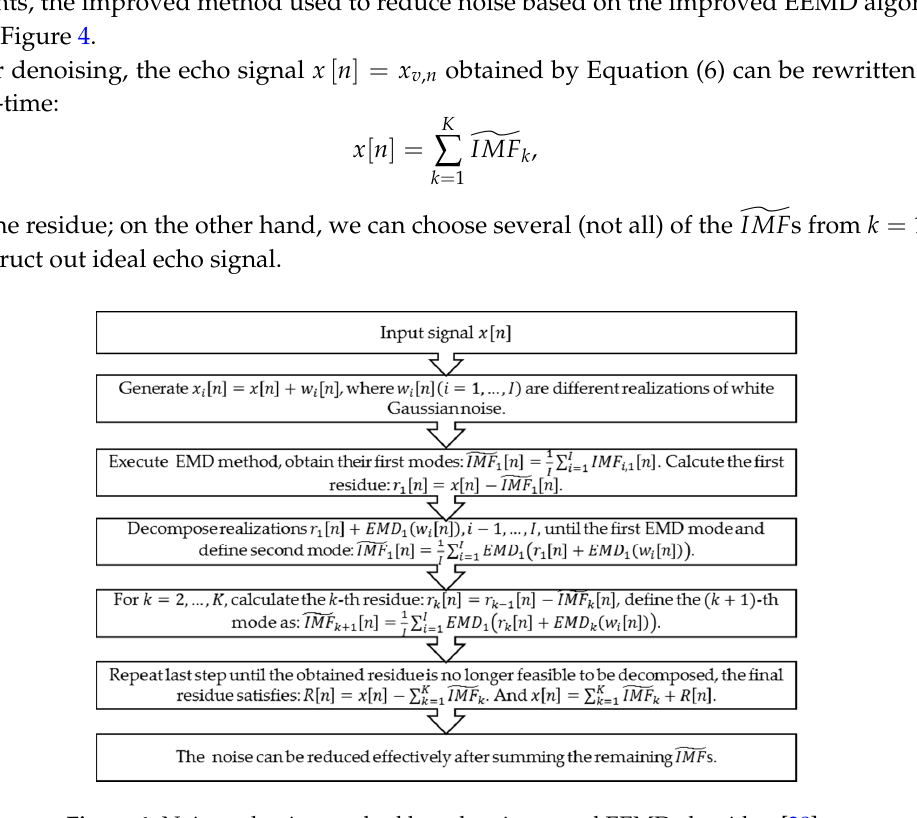
Figure 4. Noise reduction method based on improved EEMD algorithm [28].